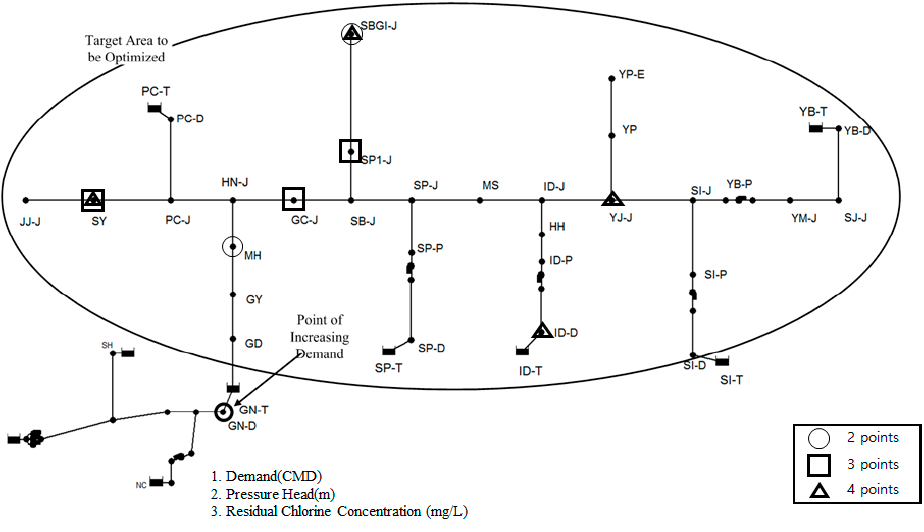
Figure 5. Optimal points under normal conditions.